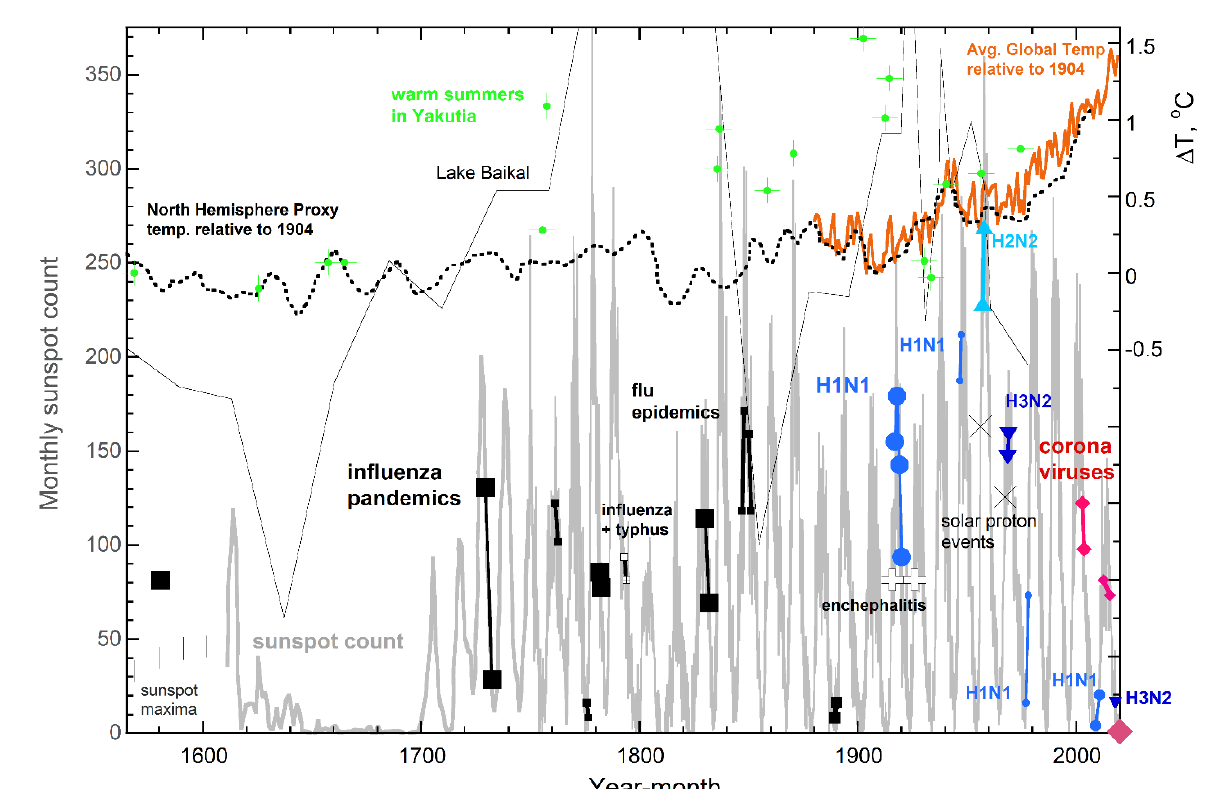
Figure 2. Comparison of pandemic onset and duration with solar phenomena and warming episodes. These correlations that began with the “first” influenza pandemic of 1580. Grey curve (left y axis) = sunspot number from [67] and Hoyt and Schatten [60], where vertical bars denote earlier maxima from Wu [63]. X = strong solar cosmic ray events [68,69]. Major pandemics (large symbols) from [1,14] plus substantial or notable epidemics (various small symbols, with labels from [70]) are placed on the sunspot curve to best depict timing. Sizes of the symbols suggest severity, e.g., the 1889 pandemic was mild. The earlier SARS and MERS are actually epidemics, but are included, being related to the ongoing pandemic. Orange solid curve (right axis) = the global temperature difference from NOAA [71]. Dotted curve = decadal averages for the NH [66]. Thin black curve = summer temperatures from insects in lake sediments near Lake Baikal close to Mongolia [64]. All curves assume ΔT is 0 °C at 1904. Green += hottest summers within 600 years from analysis of tree ring growth near the edge of permafrost [65]; vertical placement was ascertained by subtracting 10.5 °C from values in their tables, which reference value was estimated as the 1904 actual temperature in Yakutia from [65] (Figure 5).